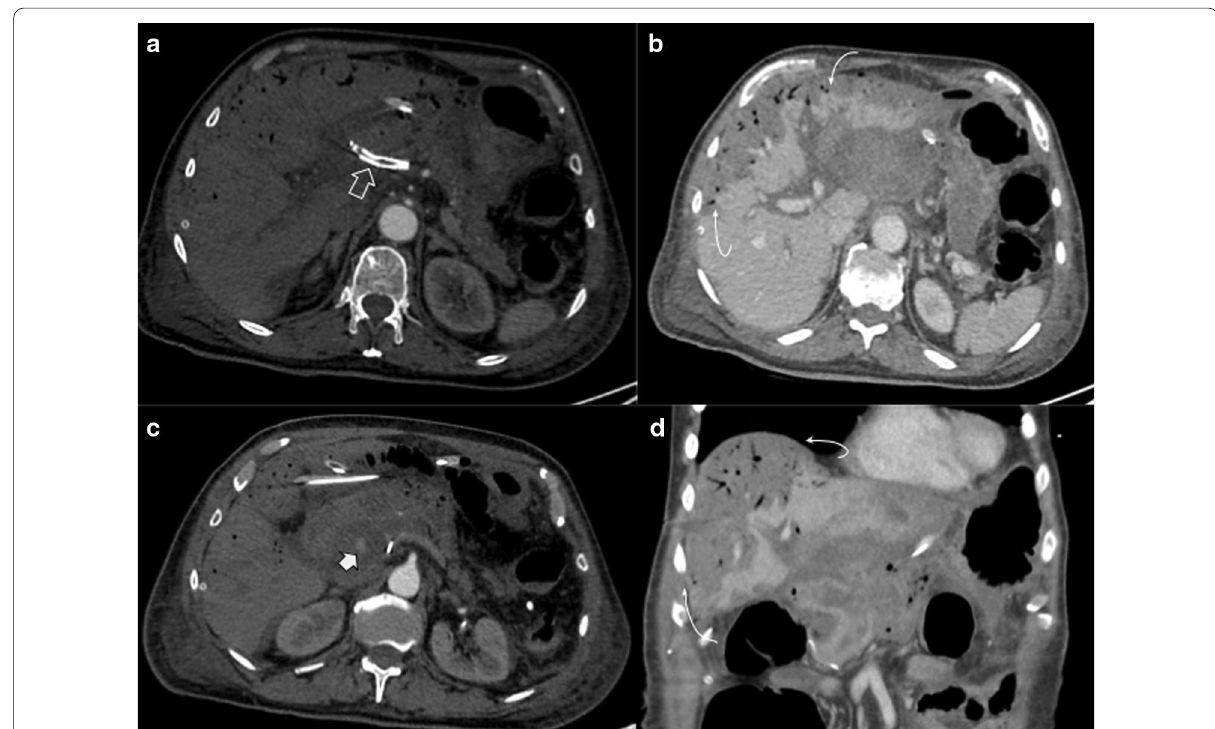
Fig. 28 Hepatic infarct. 78-year-old patient with complicated early postoperative due to pseudoaneurysm. Stent in the hepatic artery was placed. Control CT scan due to increased hematic fluid drainage evidence occluded stent (blank arrow in a ) and big subcapsular hypodense areas in liver parenchyma (curved arrows in b and d ) consisting with infarct. An active bleeding focus depending on the ligated gastroduodenal branch was also detected (big arrow in c